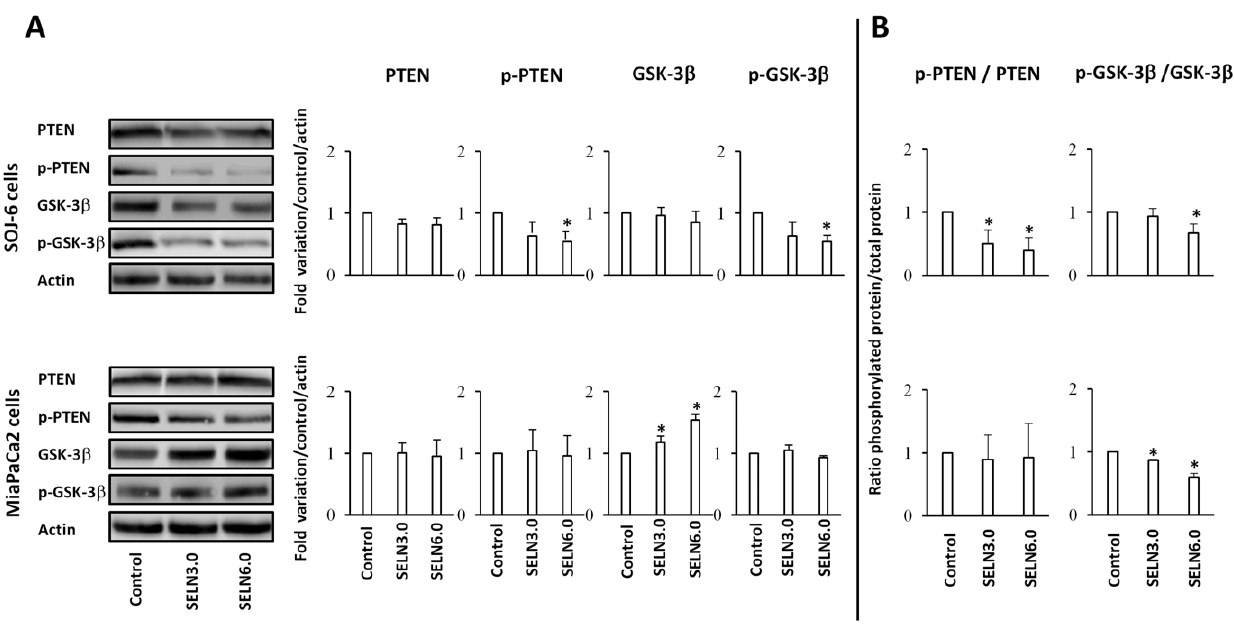
Figure 5. Effect of SELN on PTEN and GSK-3 b phosphorylation. (A) SOJ-6 and MiaPaCa-2 cells were starved then treated for 24h with SELN (16 nmoles cholesterol/ml) and lysed. Cell lysate proteins were separated on SDS-PAGE (80 m g of proteins/lane) and electrotransferred onto nitrocellulose membrane. The levels of PTEN, Ser380-phosphorylated PTEN (p-PTEN) GSK-3 b , Ser9-phosphorylated GSK-3 b (p-GSK-3 b ) and b -actin were determined by probing membranes with specific antibodies as indicated. Western blots are representative of three independent experiments. Lane 1, control performed in the absence of SELN, Lane 2, in the presence of SELN 3.0, Lane 3, in the presence of SELN 6.0. The right panels in figure 5A represents the quantification of western blots. (B) Ratios of Ser380-phosphorylated PTEN (p-PTEN) to total PTEN and Ser9-phosphorylated GSK-3 b (p-GSK-3 b ) to total GSK-3 b determined from A. Results are means ( 6 SD) of three independent experiments using the NIH Image program (Mann-Whitney test).